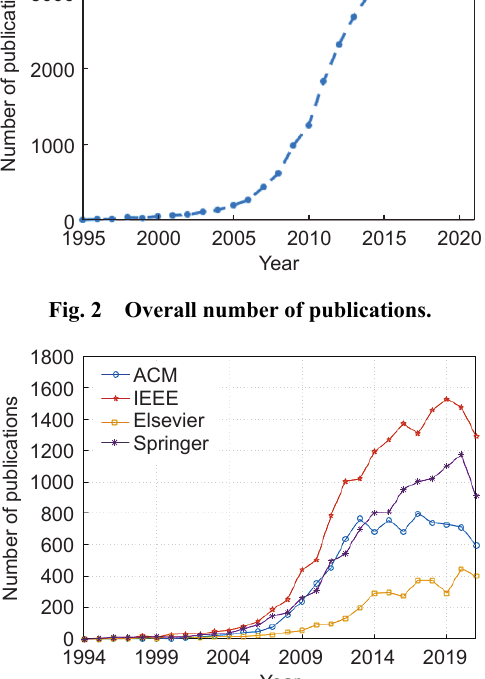
Fig. 3 Number of publications of each